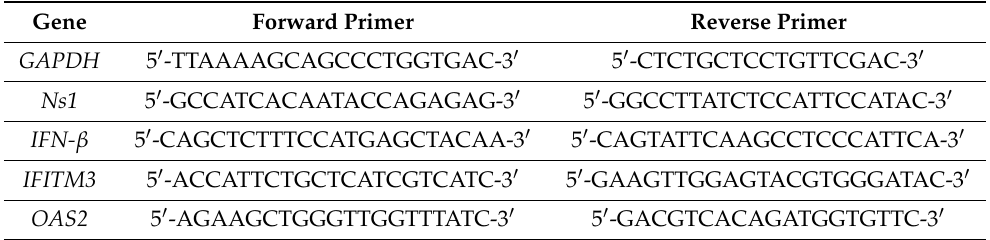
Table 1. Primers used in